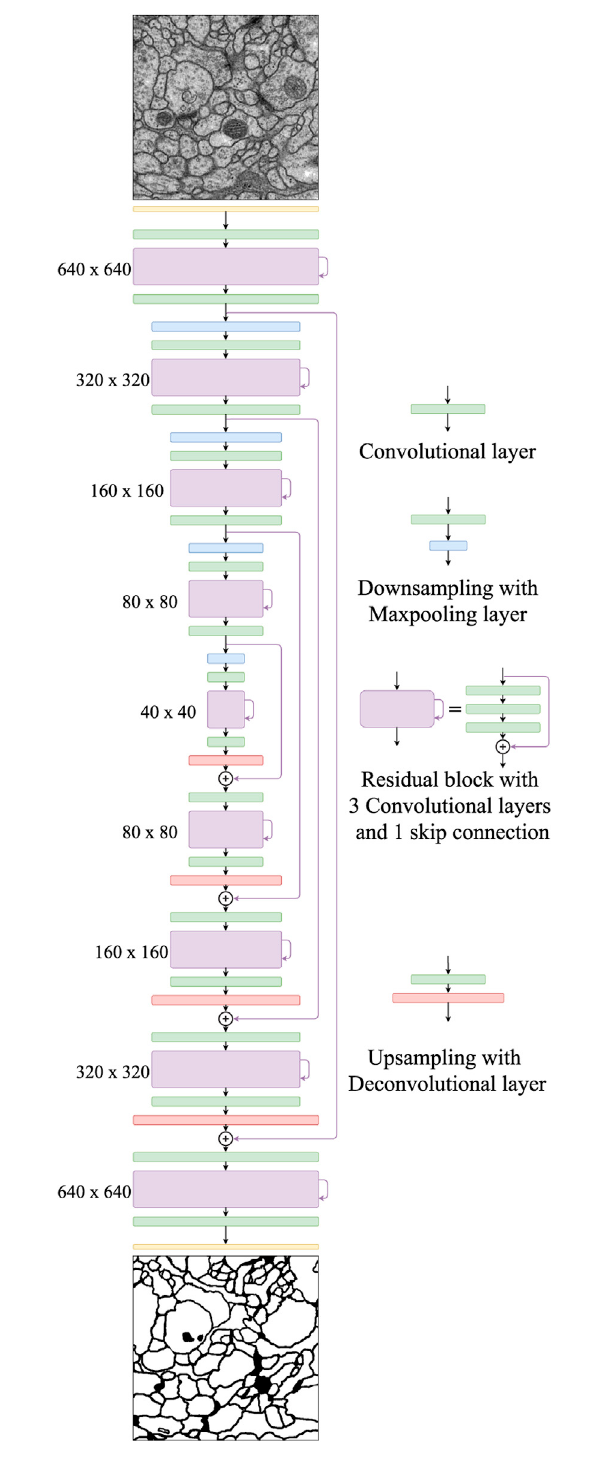
FIGURE 2 | The proposed FusionNet architecture. An illustration of the encoding path (top to middle) and the decoding path (middle to bottom) . Each intermediate residual block contains a residual skip connection within the same path, while the nested residual skip connections connect two different